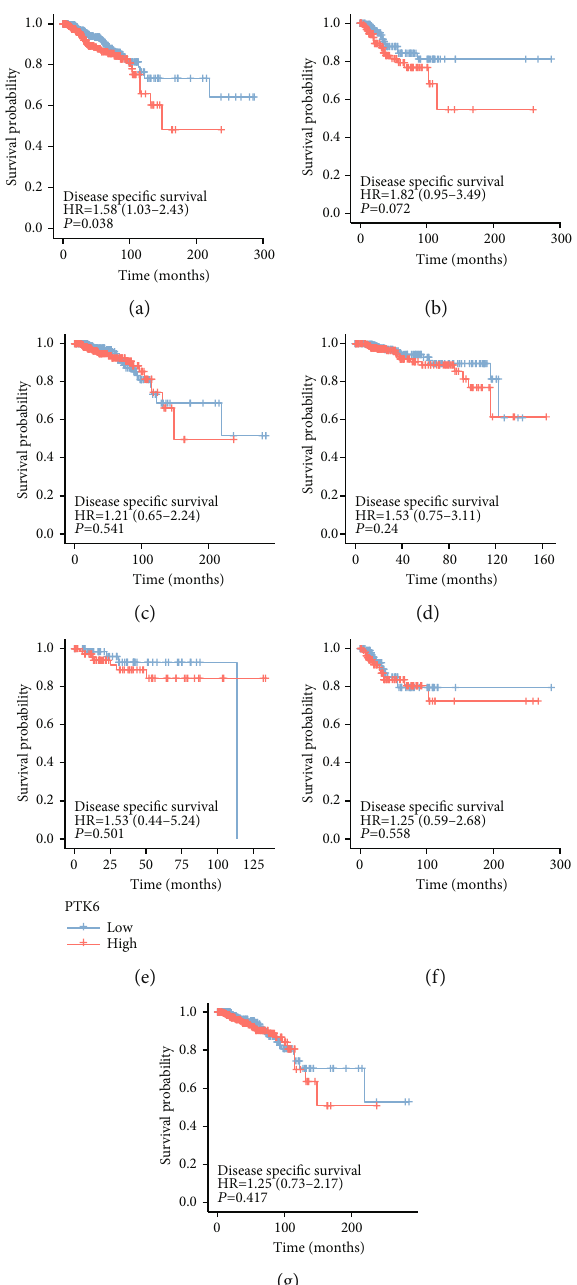
Figure 7: Survival curves were calculated using Kaplan-Meier assays for the exploration of the possible in fl uence of PTK6 expression on disease-speci fi c survival of BC patients. (a) All BC patients. (b) Patients with negative PR status. (c) Patients with positive PR status. (d) Patients with negative HER2 status. (e) Patients with positive HER2 status. (f) Patients with negative ER status. (g) Patients with positive ER